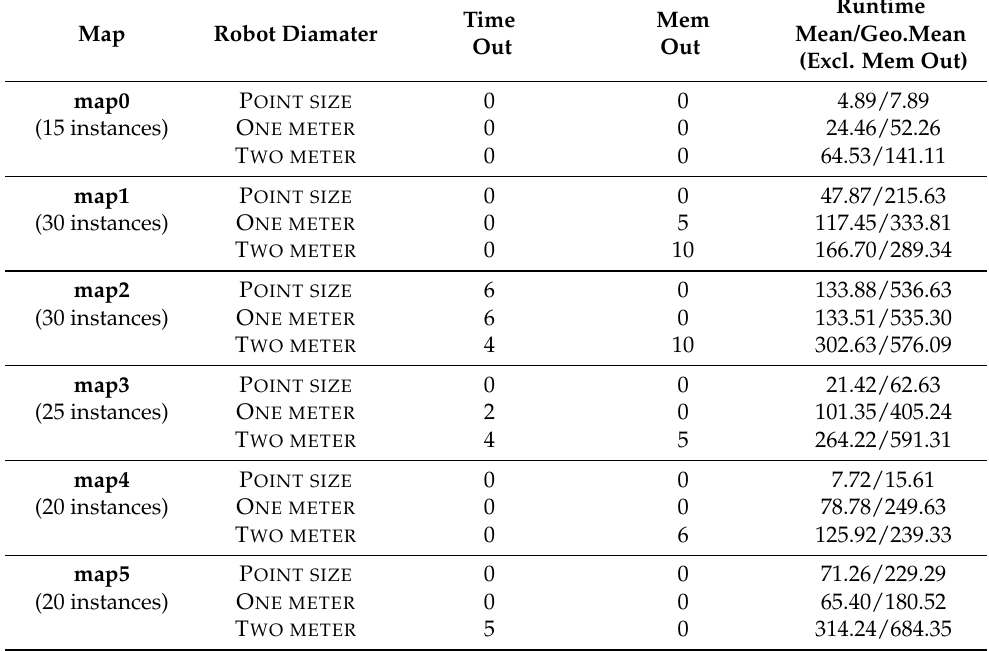
Table 8. Comparison of solving for a point-sized robot vs. a circular one and two meter diameter robot, for the high performance path encoding variant P ATH + LB + C ORR (S) + T SK A CYC (W) + M V A + M V R +